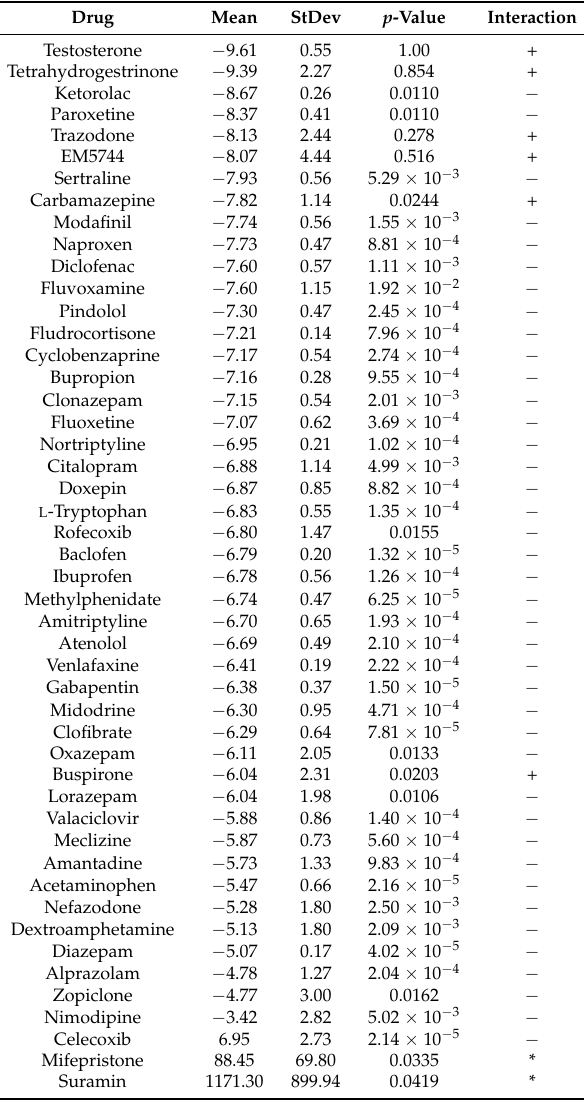
Table 5. Interaction of common drugs used to treat GWI symptoms with AR agonist form. Mean binding energy and standard deviation are in units of kcal/mol. A t -test was used to compare to the known binder testosterone. (+) indicates putative binding, ( − ) indicates no putative binding, (*) indicates more in-depth analysis